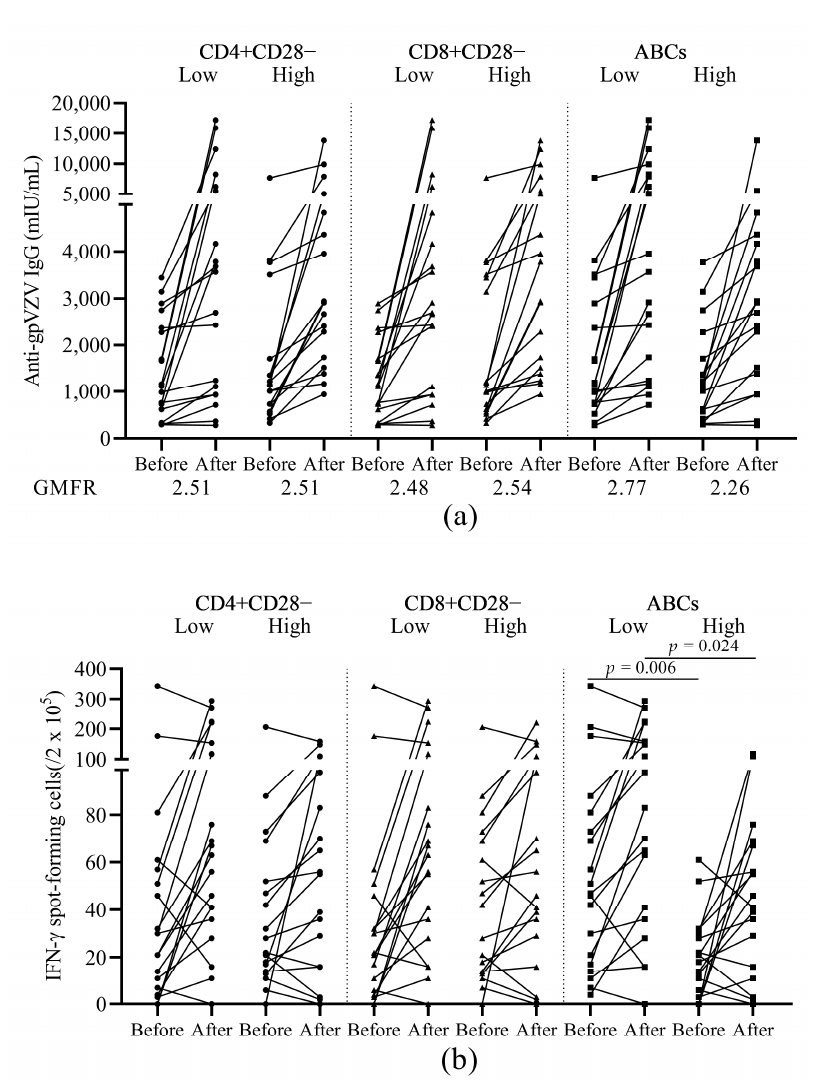
Figure 3. Humoral and cellular immunogenicity of the HZ vaccine in patients with low or high baseline frequencies of ageing cell subsets. ( a ) Levels of anti-glycoprotein (gp) VZV IgG antibody before and after vaccination. GMFR after vaccination over before vaccination is shown under the figure. ( b ) The number of VZV stimulated IFN- γ secreting T cell spots before and after vaccination. HZ, herpes zoster; gp, glycoprotein; VZV, varicella zoster virus; GMFR, geometric mean fold rise; ABCs, age associated B cells. Patients were divided into subgroups according to their baseline frequencies of ageing subsets (CD4+CD28−, CD8+CD28−, or ABCs) lower or higher than the median level.